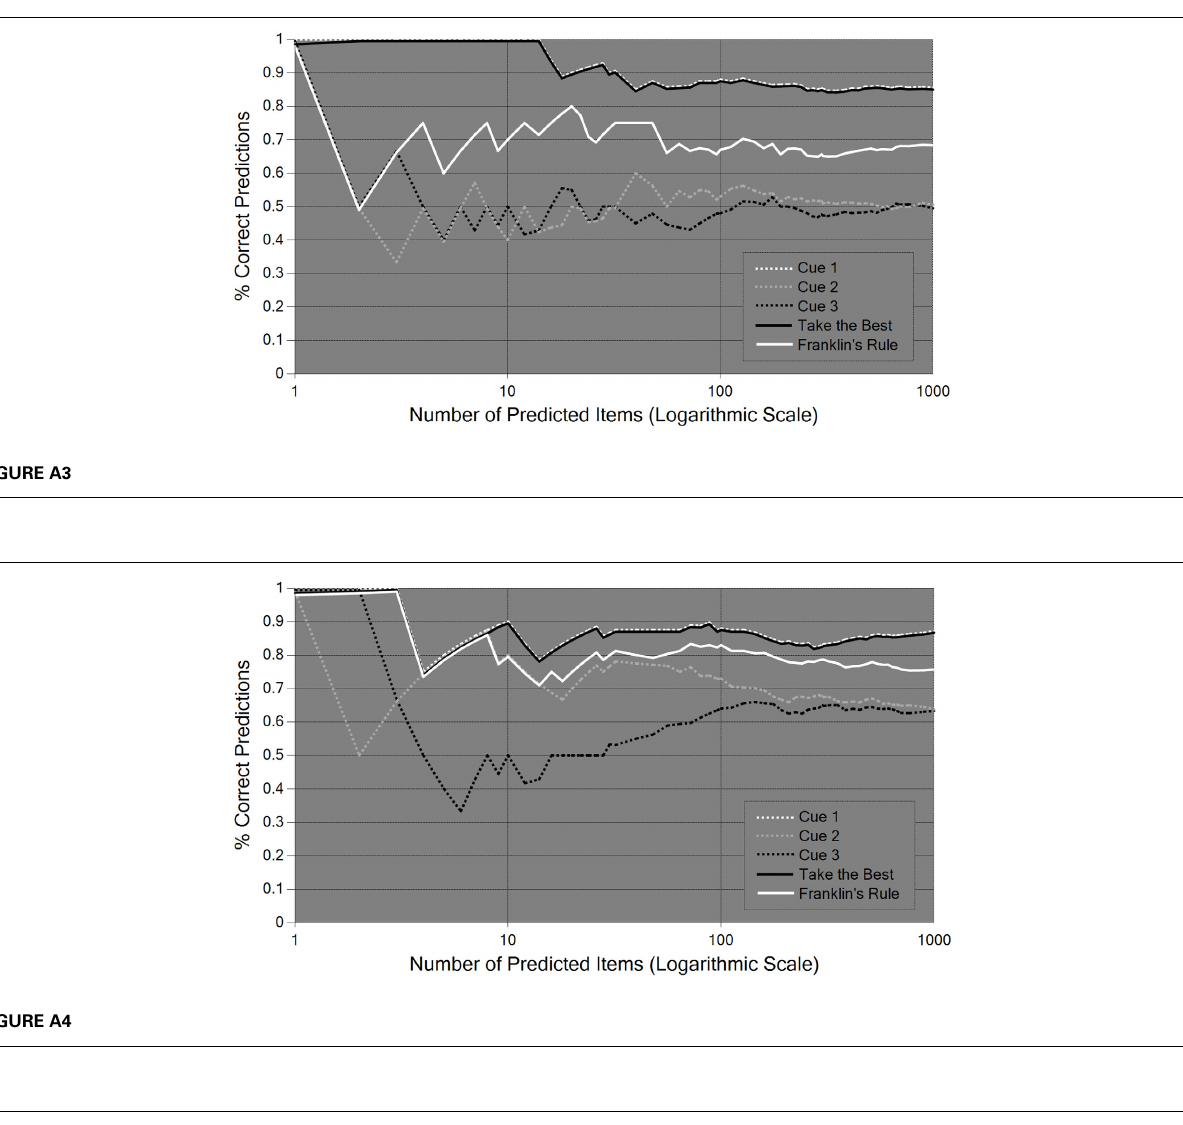
FIGURE A3 + A4 | TTB against Franklin’s rule in a binary prediction tournament with known validities which are conditionally independent. Figure A3 with low redundancy and Figure A4 with high redundancy of cues. In both cases TTB predicts better than Franklin’s rule.